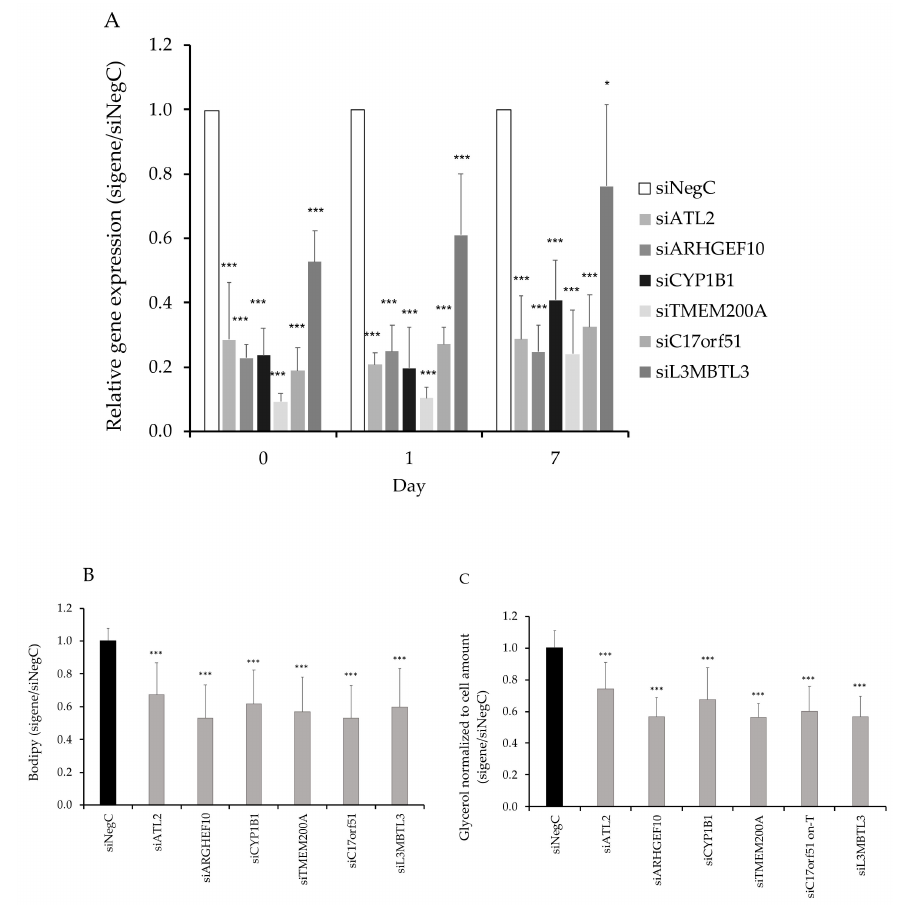
Figure 3. ( A ) ATL2, ARHGEF10, CYP1B1, TMEM200A, C17orf51, and L3MBTL3 was knocked down using small interfering RNAs (siRNA) in hMSCs four days (day − 4) before induction of di ff erentiation and followed until di ff erentiation day 7 and 9. ( B ) Accumulation of neutral lipids was evaluated with Bodipy staining of cells at day 9. ( C ) Glycerol amount in the medium was measured, and all measured concentrations were within the range of the glycerol standard curve 0–120 µ M. Results were analyzed using a t -test and presented in fold change ± SD relative to negative control of a corresponding time point (Neg C). *** p < 0.005, ** p < 0.01, * p <